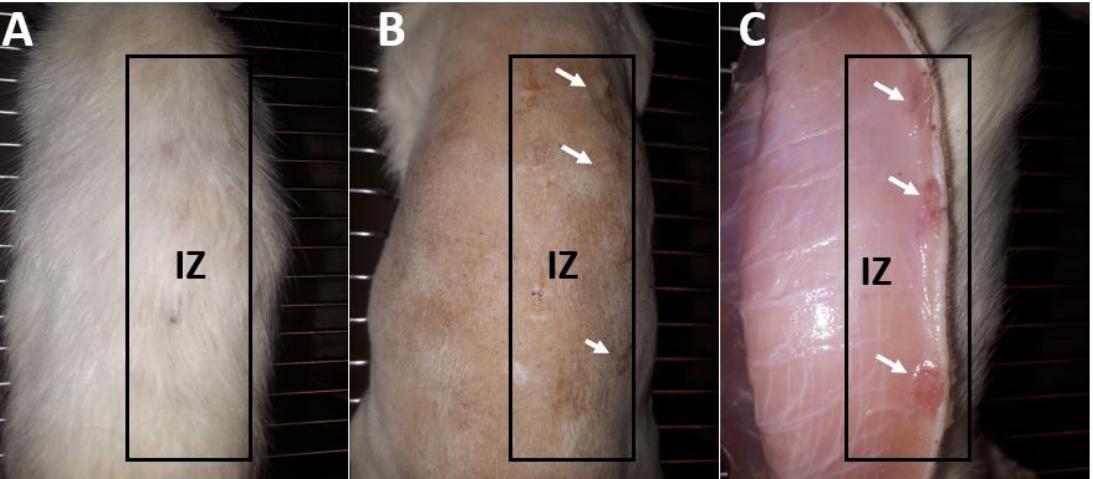
Figure 12. Macroscopic image of a biomodel implanted at 30 days. ( A ). Dorsal image. ( B ) Dorsal image with a trichotomy. ( C ) Inner surface of the skin. IZ: Implantation zone. White arrows: Implantation sites.